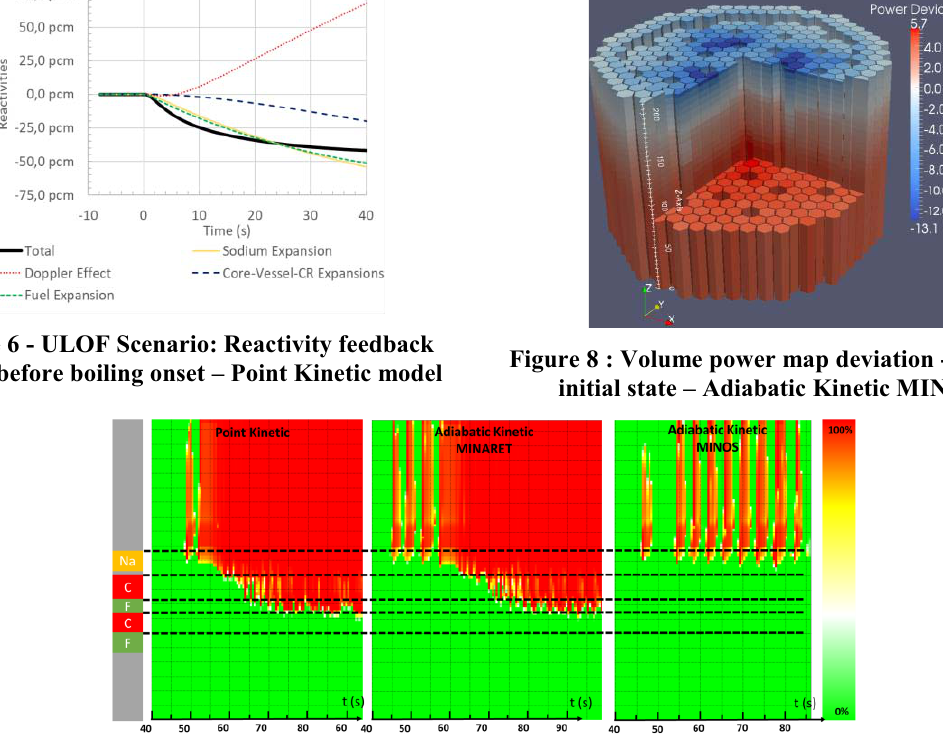
Figure 9 : Boiling front evolution - Hottest Assembly –Void rate (%) –Point vs. Adiabatic